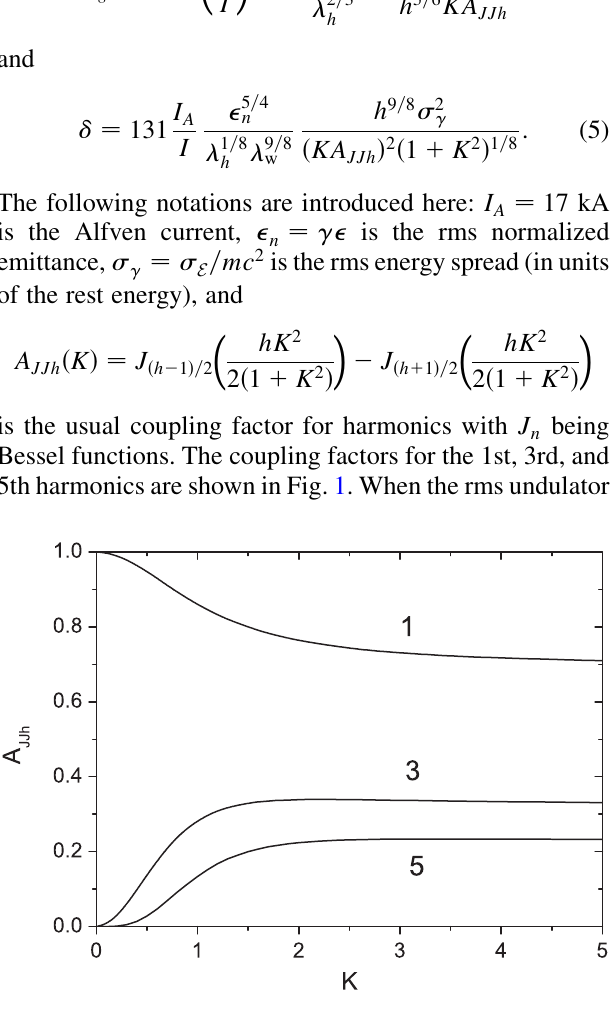
FIG. 1. Coupling factors for the 1st, 3rd, and 5th harmonics (denoted with 1, 3, and 5, correspondingly) versus rms undulator